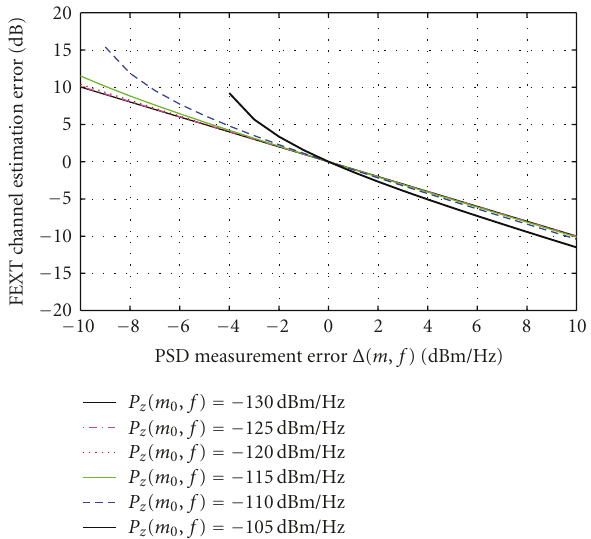
Figure 17: The FEXT channel estimation error in (29) as a function of the PSD measurement error Δ ( m ) and the received background noise P z ( m 0 ). The received FEXT PSD P y ( m ) from the neighboring line is here fixed to − 100